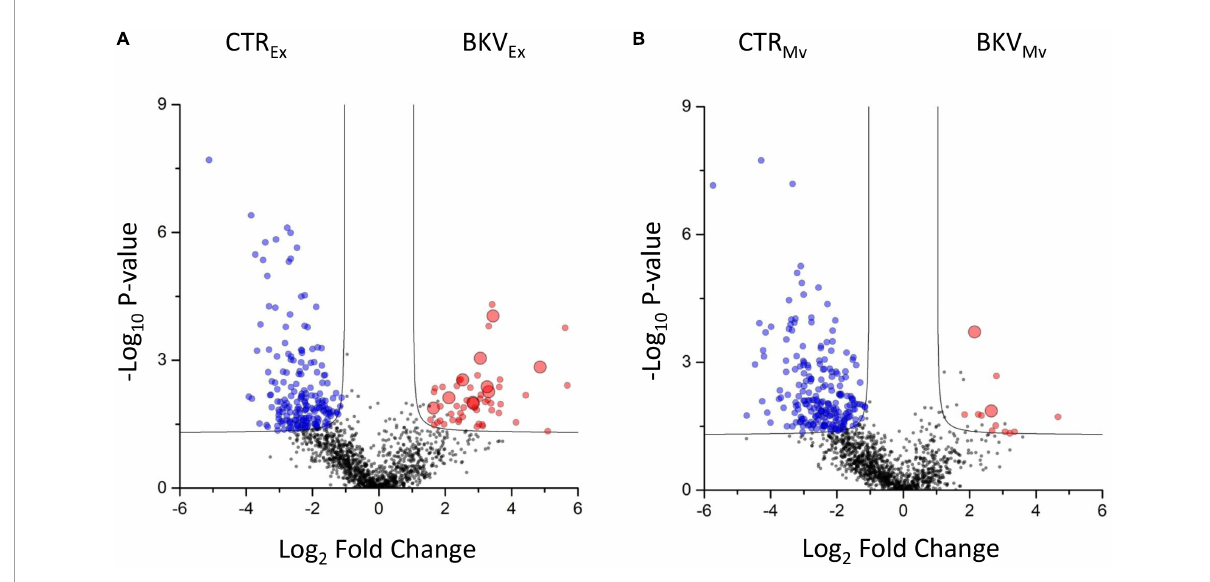
FIGURE4 Volcano plot showing the univariate statistical analysis of exosomes and microvesicles from patients with BKV infection and control (CTR). The plots are based on the fold change (log 2 ) and the P -value (–log 10 ) of all proteins identified in (A) exosomes and (B) microvesicles. Red, blue and black circles represent up-regulated, down-regulated and non-differentially expressed proteins, respectively, in patients with BKV infection vs. CTR. Black line indicates the limits of statistical significance (adjusted p- value ≤ 0.05 and fold change ≥ 2).